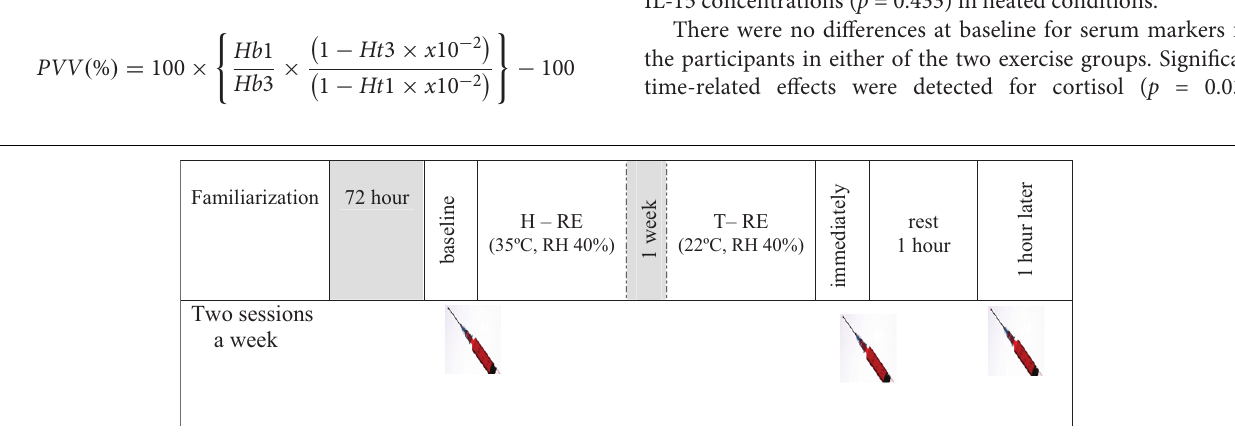
FIGURE 1 | Schematic representation of experimental protocol. H-RE: heated resistance exercise, T-RE: thermoneutral resistance exercise.